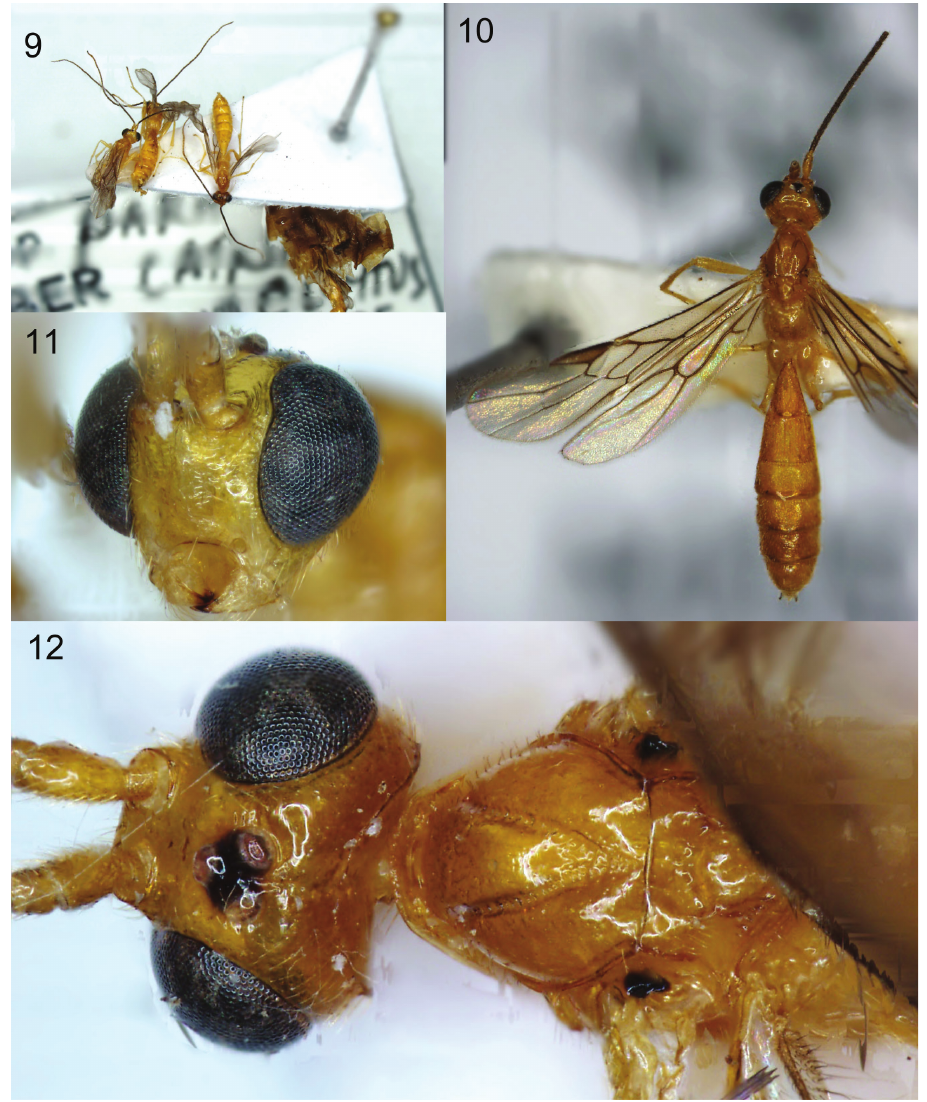
Table 1 for all data on 30 additional rearings totalling 33 paratypes. Specimens USNM ENT 00491800, USNM ENT 00491811 and USNM ENT 00648414 are deposited in the